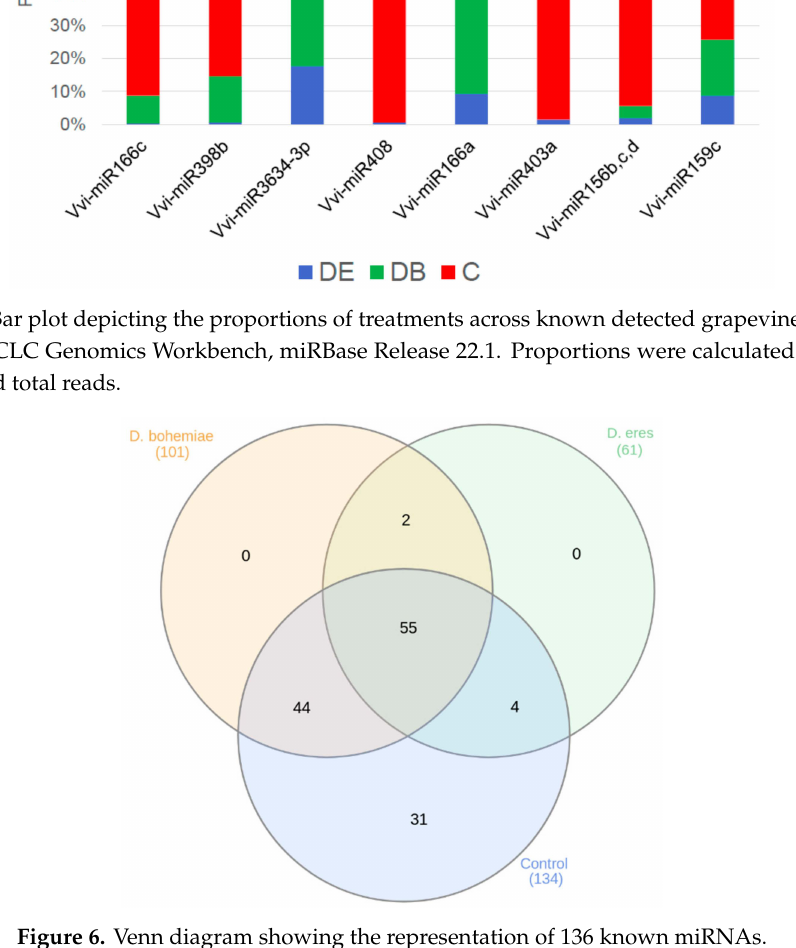
Figure 6. Venn diagram showing the representation of 136 known